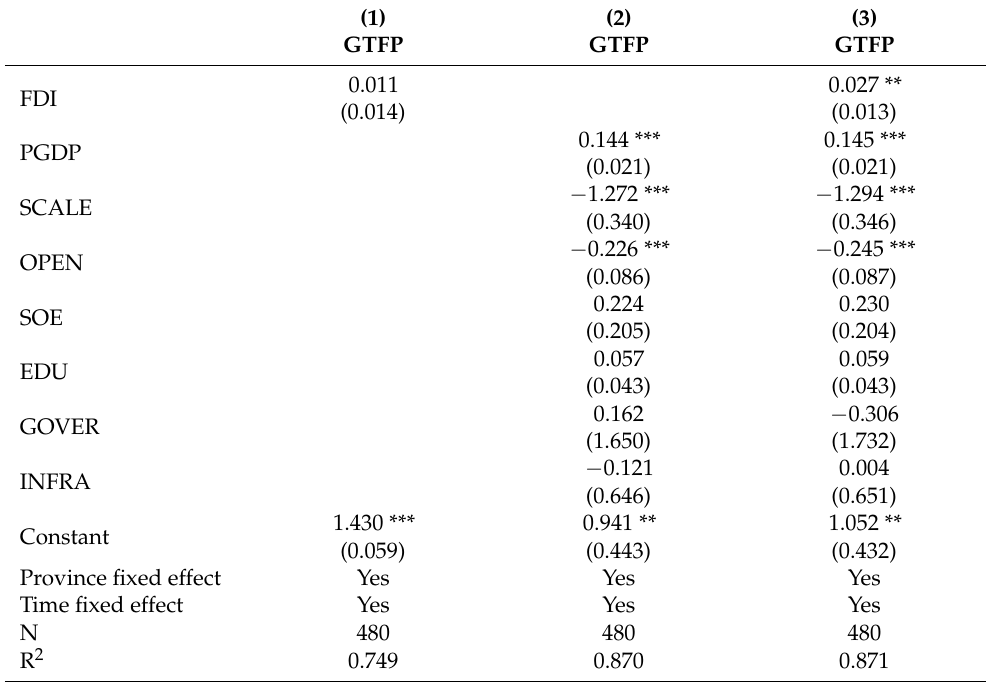
Table 3. Baseline regression